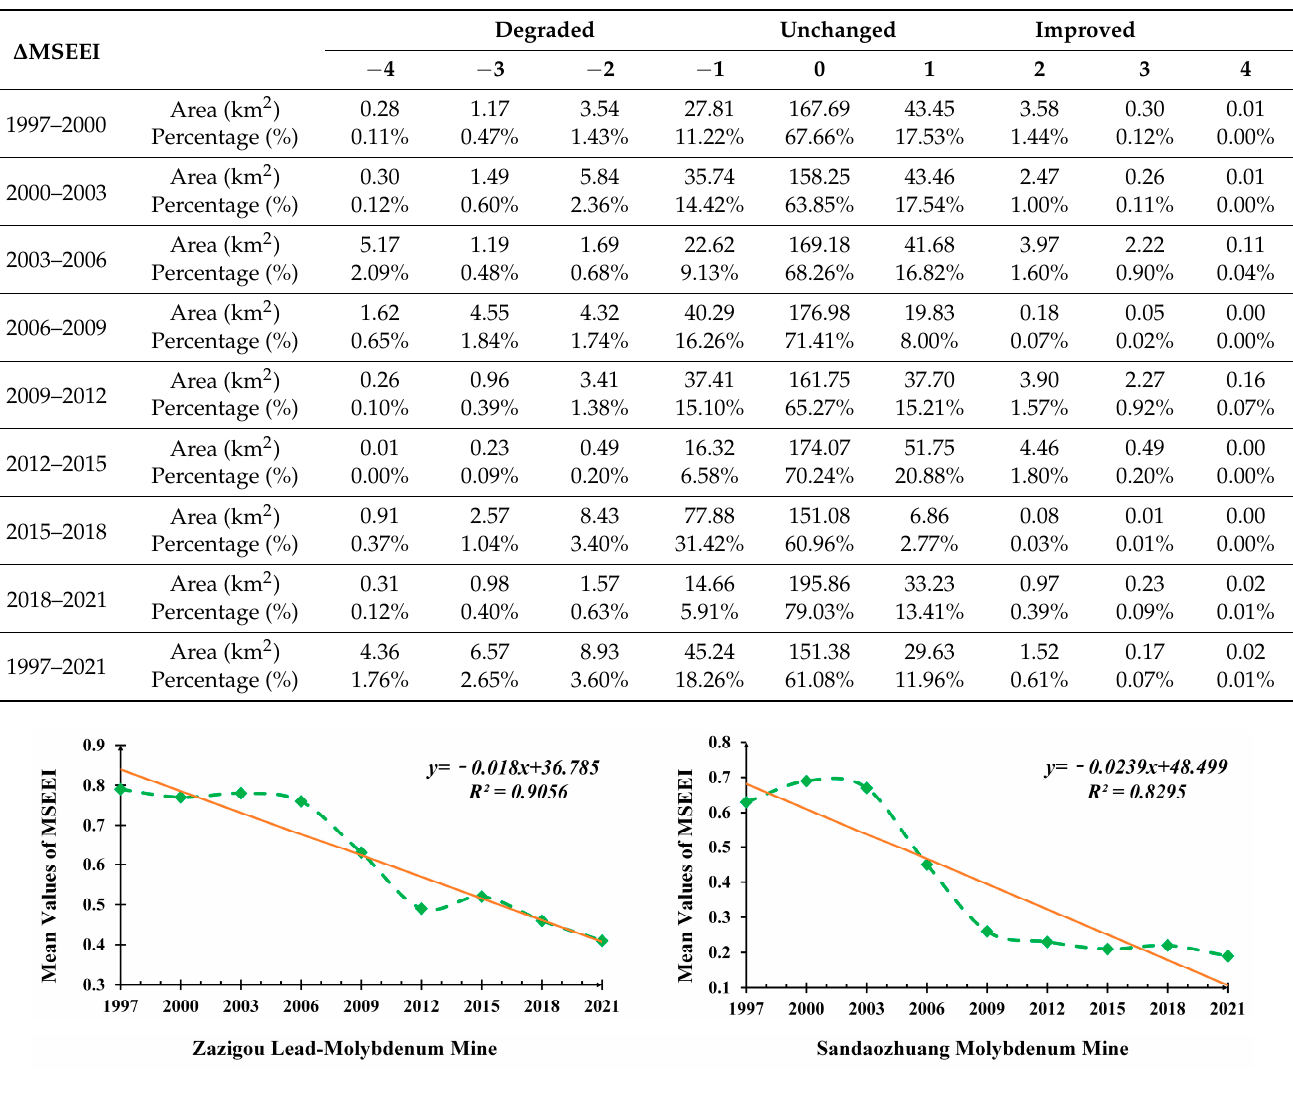
Table 4. MSEEI grades change detection from 1997 to 2021.